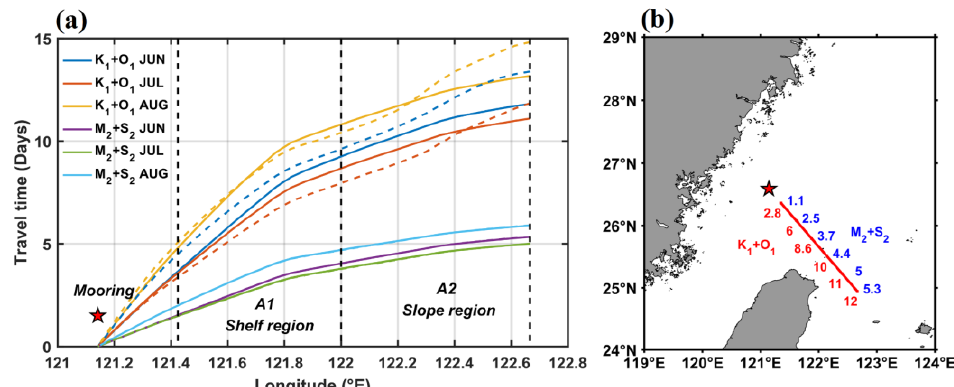
Figure 10. ( a ) Cumulative travel time of diurnal (K 1 + O 1 ) internal tides and semidiurnal (M 2 + S 2 ) internal tides along the propagation path of internal tide. The path is the same as the one shown in (Figures 6, 8, and 10b), except ahead of the starting point to mooring location. The travel times are estimated by group velocity of K 1 + O 1 and M 2 + S 2 waves using WOA 18 monthly-mean stratification. The dash lines indicate the travel times considering the monthly mean background current of the month with the same color as solid lines. The mooring location, A1 and A2 demarcation lines (same as Figure 6) are marked for reference. ( b ) The schematic of the travel times along the propa- gation path. Semidiurnal and diurnal internal tide travel times in August (Unit: days) are labeled in blue and red as reference, respectively.